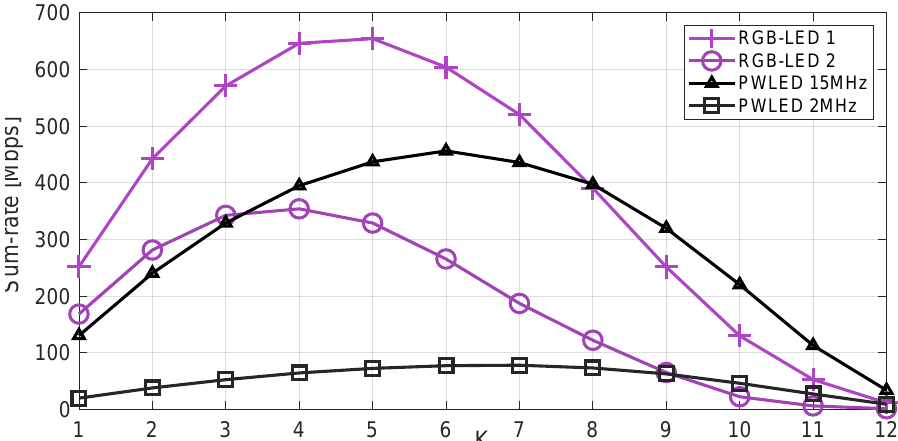
Figure 6. Sum rate versus the number of users for the pseudo-inverse precoder. “RGB-LED” refers to a system with N = 12 RGB units, each unit composed of one red, one green, and one blue LED colocated together. “PWLED” refers to a system with twelve phosphor-coated